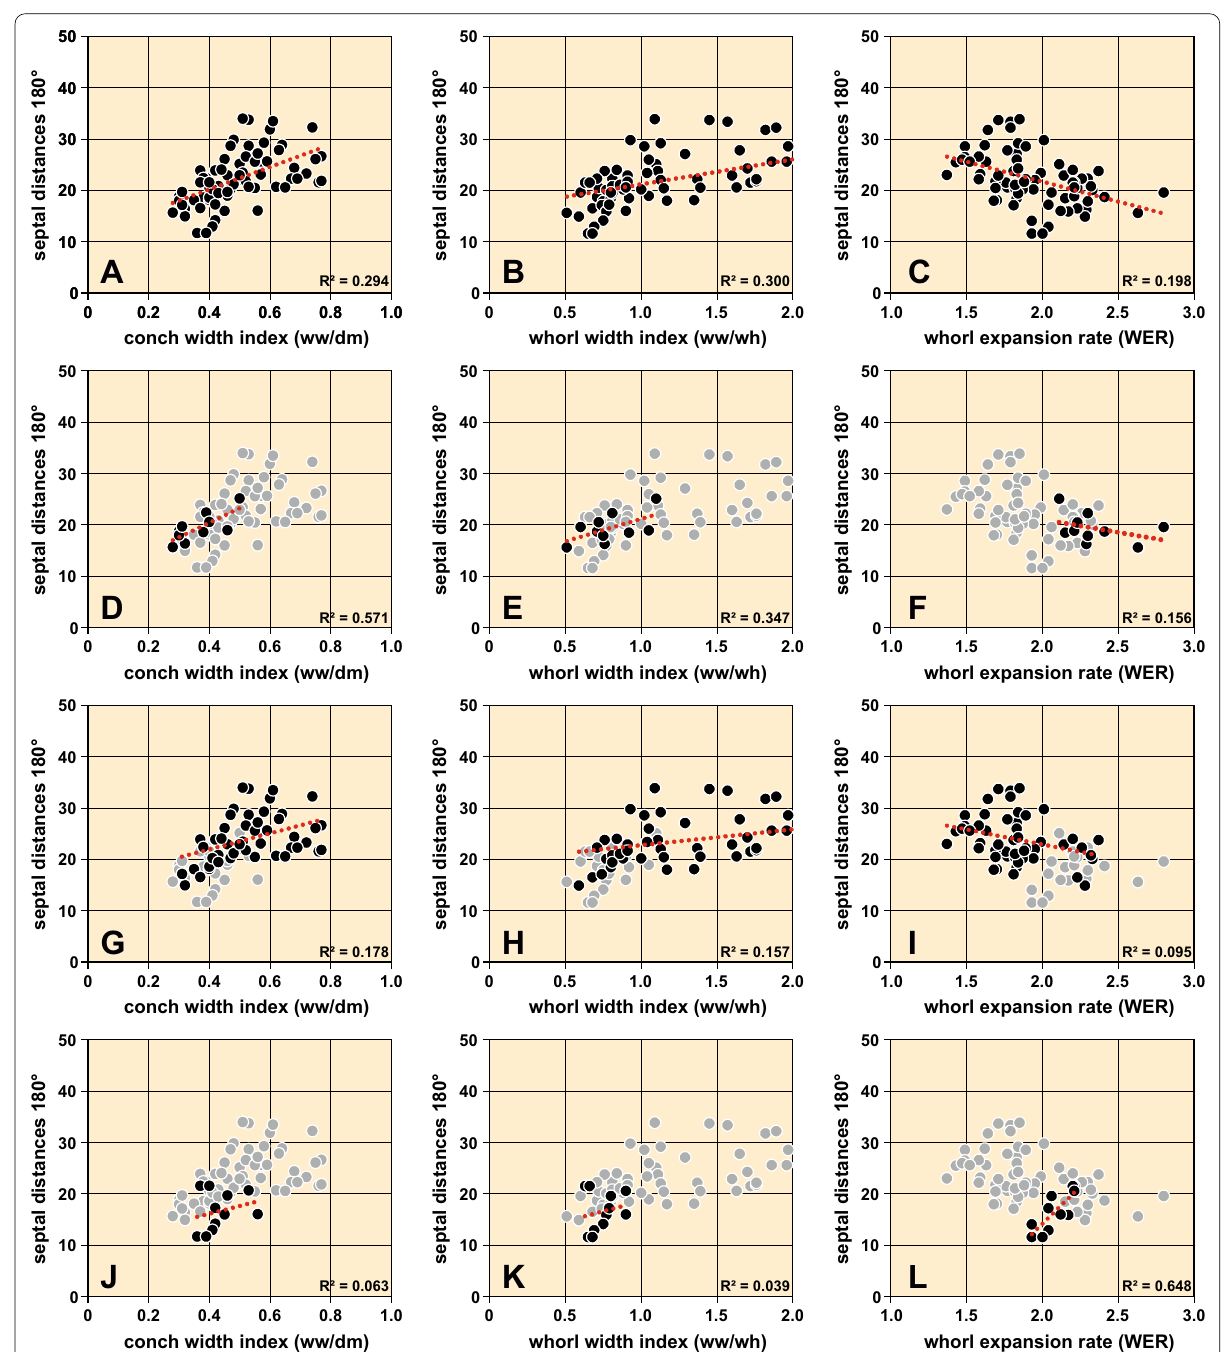
Fig. 10 Bivariate plots of conch parameters and septal spacing (of the last half volution) in the Late Givetian assemblage of Hassi Nebech (grey background dots represent the entire sample). A , D , G , J Conch width index (ww/dm) and septal spaces. B , E , H , K Whorl width index (ww/wh) and septal spaces. C , F , I , L Whorl expansion rate (WER) and septal spaces. A – C Complete assemblage. D – F Suborder Gephuroceratina. G – I